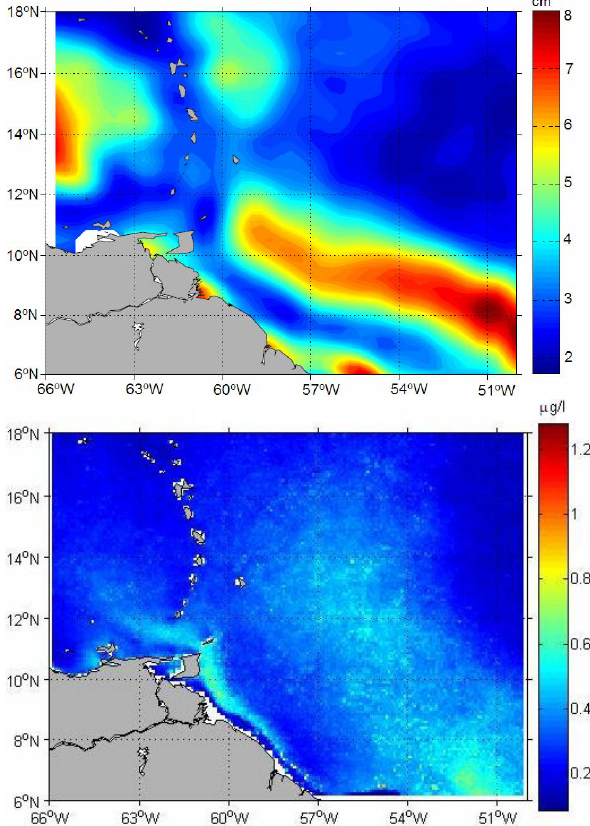
Fig. 2. Root-mean square of SHA data (in cm) for the period of 1993–2004 (top) and chlorophyll- a mean (in µ g/l) for the period of Figure 2. Root-mean square of SHA data for the period of 1993-2004 (top) and 1997–2004 (bottom). chlorophyll- a mean for the period of 1997-2004 (bottom). Figure 3. Okubo-Weiss parameter ( 212 sec103.5 −− ⋅= R ) distribution during April-June Fig. 3. Okubo-Weiss parameter ( R = 5 . 3 × 10 − 12 s − 2 ) distribution during April–June 1993 (top) and October–December 1993 (bot- 1993 (top) and October-December 1993 (bottom). Positions of the rings every 7 days tom). Positions of the rings every 7 days are shown by circles. are shown by circles. Characteristic pathways of NBCR tracked every 7 days from Characteristic pathways of NBCR tracked every 7 days from im- age to image are shown by blue image to image are shown by blue arrows.